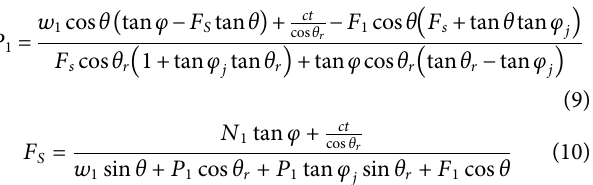
Frontiers in Earth Science |